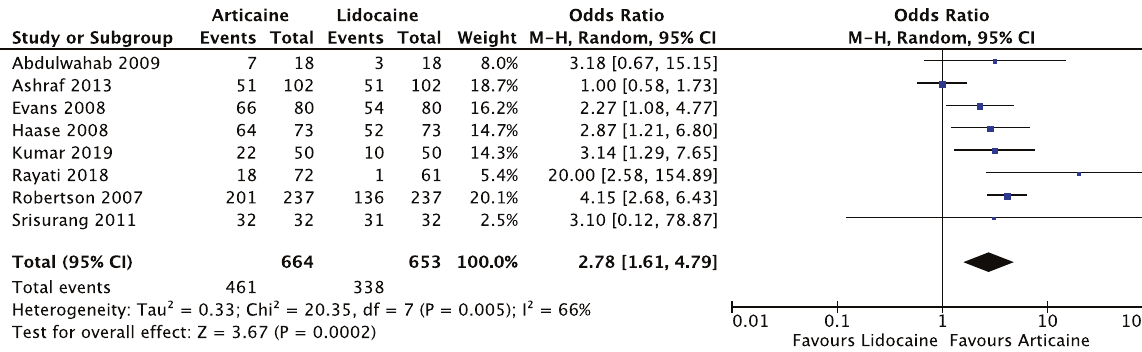
Fig. 9 Forest plot — all in fi ltrations, maxillary and mandibular. Articaine had 2.78 times likelihood of anaesthetic success of lidocaine.